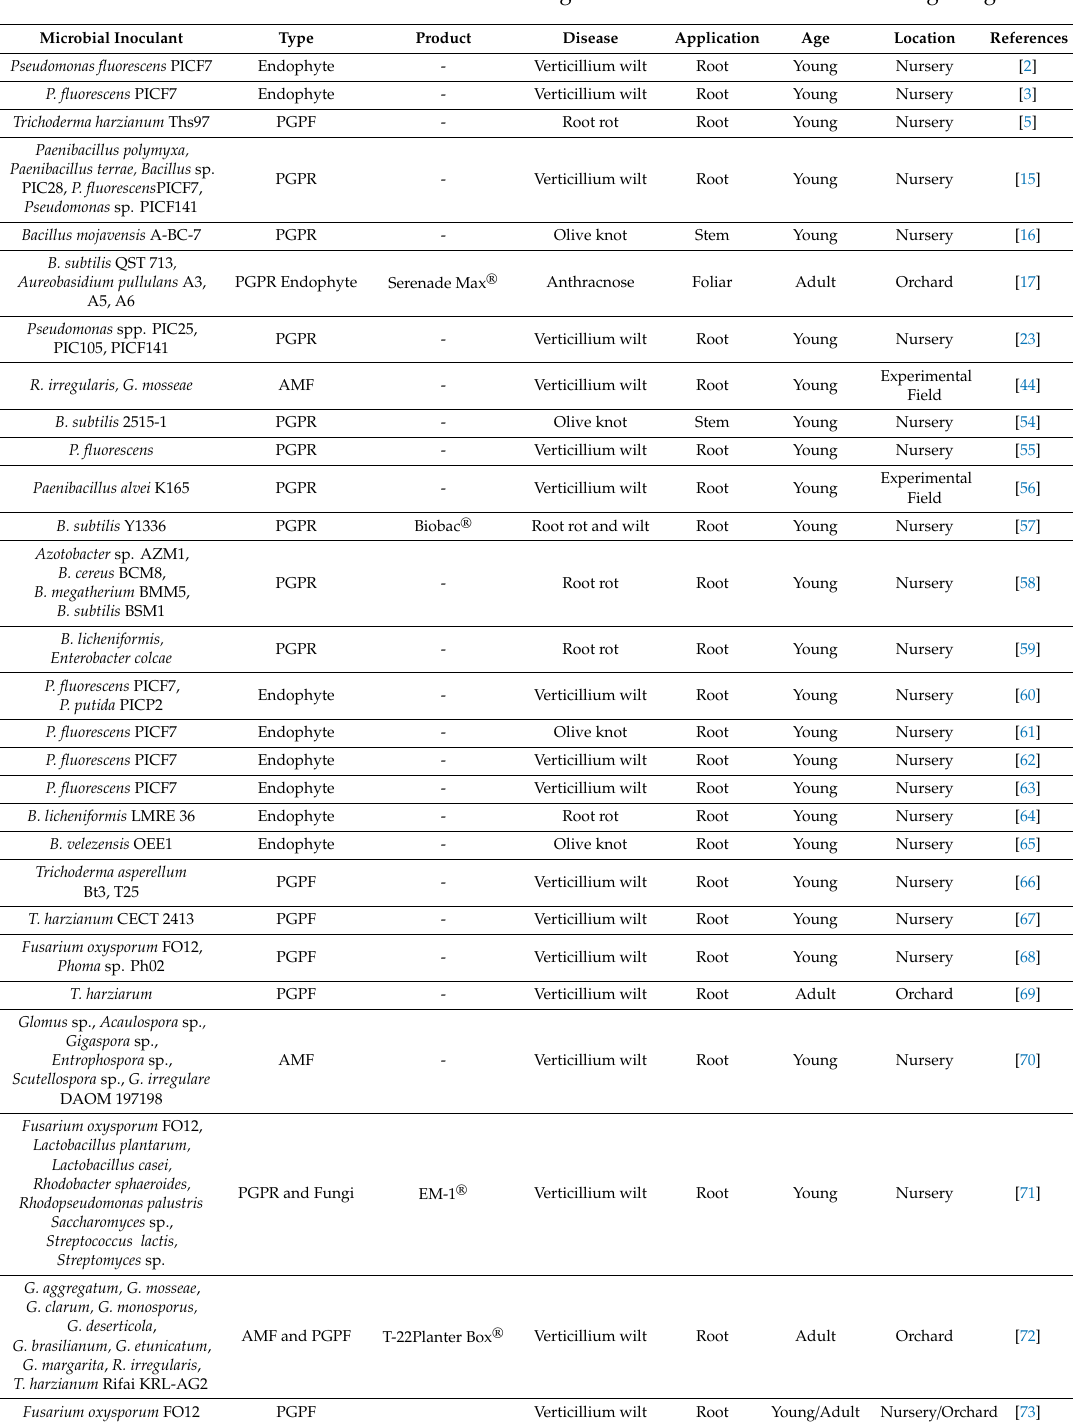
Table 3. Microbial inoculants used as biocontrol agents. PGPF: Plant Growth Promoting Fungi. Microbial